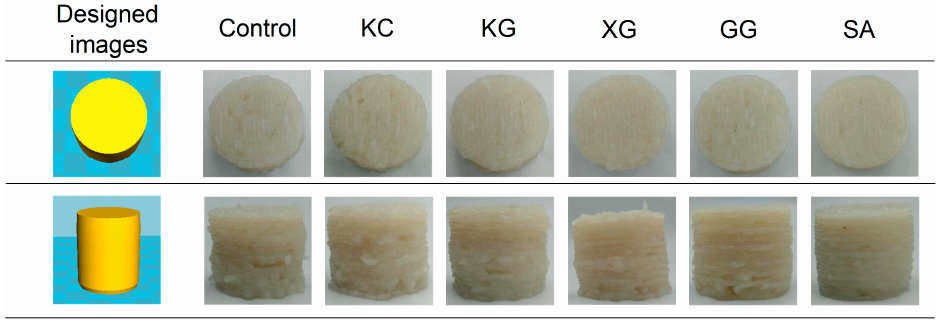
Figure 4. Three-dimensional printing effect of unwashed surimi with different polysaccharides. KC: κ -carrageenan; KG: konjac gum; XG: xanthan gum; GG: guar gum; SA: sodium alginate. Table 1. Printing time, weight and dimension deviation of raw surimi ink.